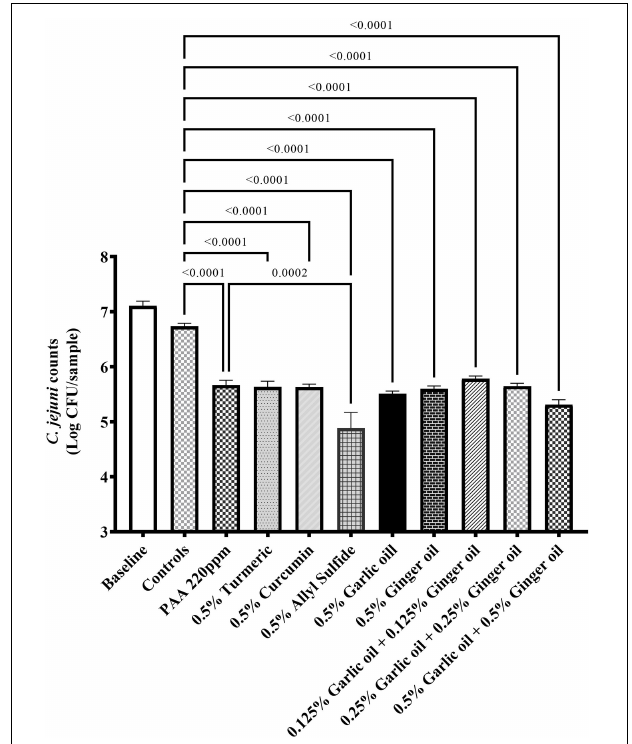
FIGURE 2 | Antimicrobial efficacy of phytochemicals as chill tank treatment at 0.5% dose and three combinations of garlic oil and ginger oil in reducing C. jejuni strain S-8 on chicken skin. Chicken skin samples were inoculated with 7.6 Log CFU/sample of C. jejuni . Results are averages of two independent trials, each containing triplicate samples (mean and SEM). The estimated p -values < 0.05 are included above the